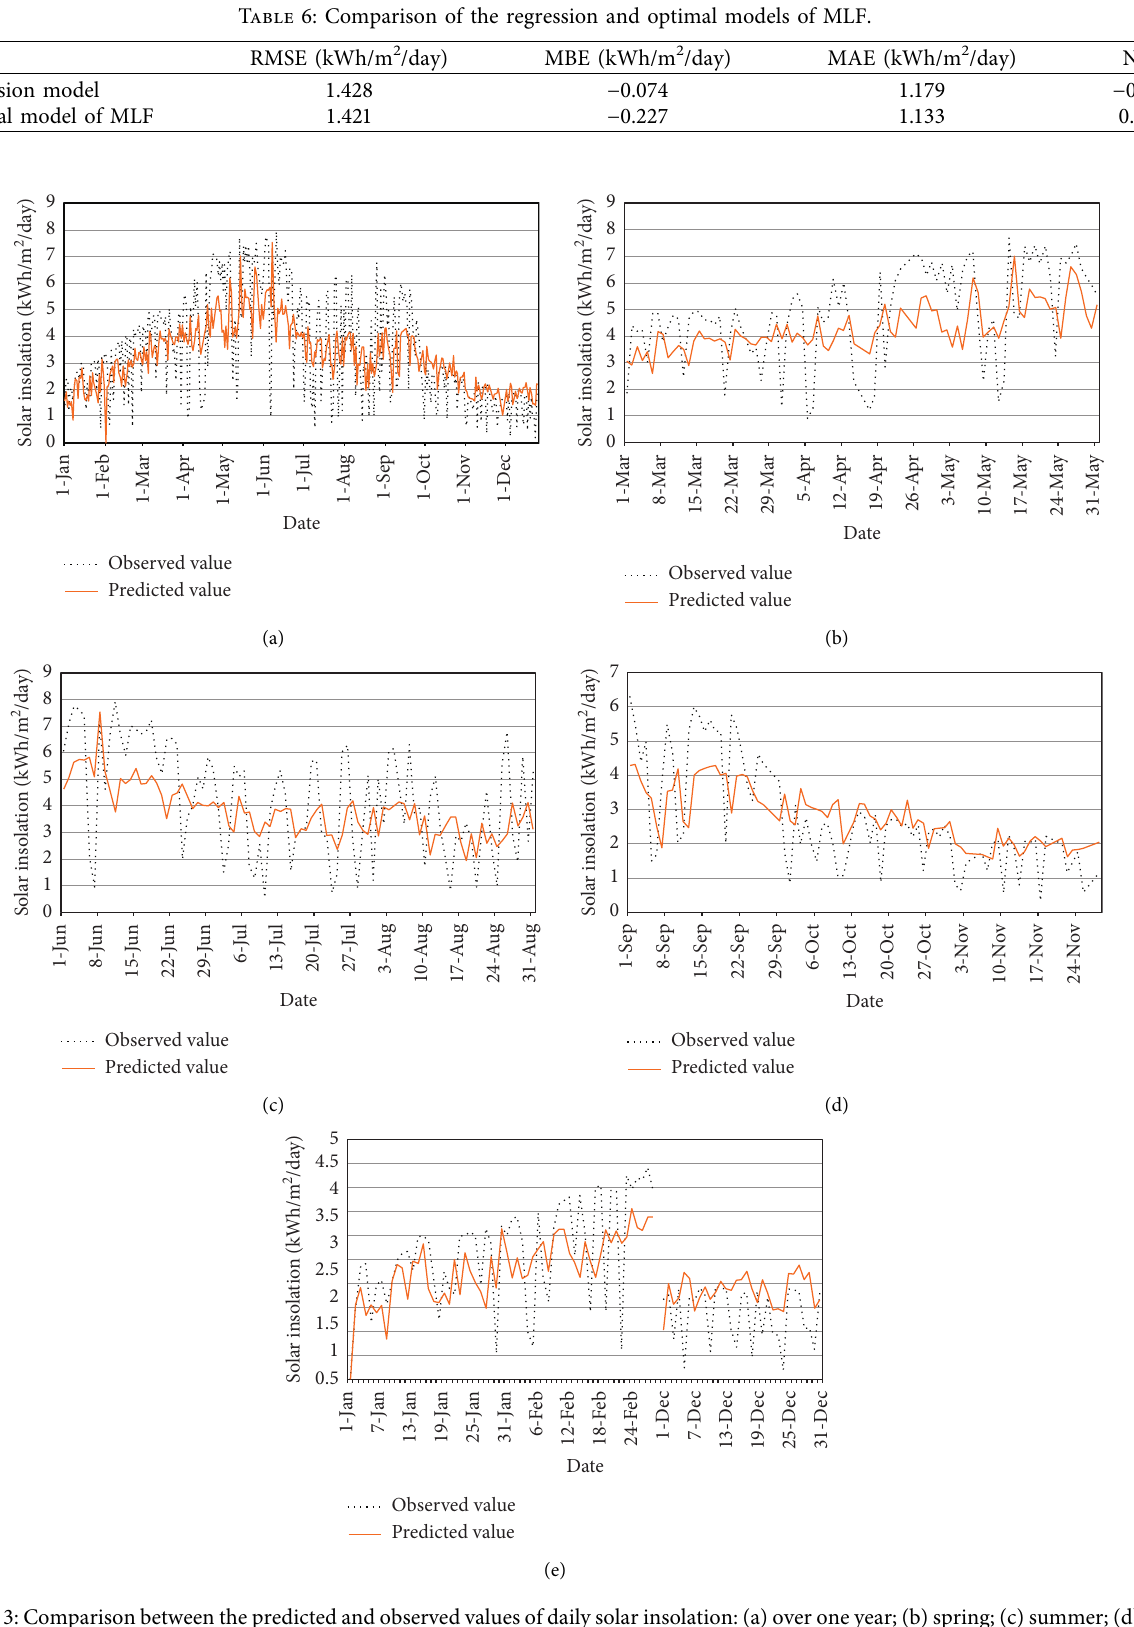
Figure 3: Comparison between the predicted and observed values of daily solar insolation: (a) over one year; (b) spring; (c) summer; (d) fall; (e)